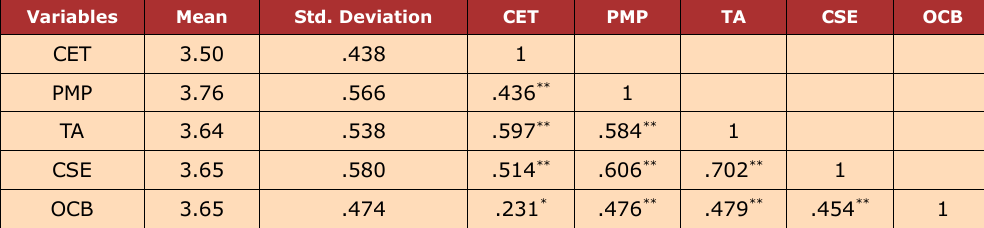
Table 4. Correlations among the dimensions of SI and